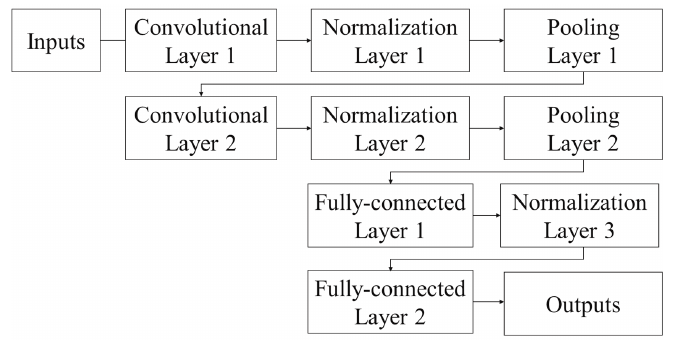
Figure 2. Architecture of the CNN networks used in this study.